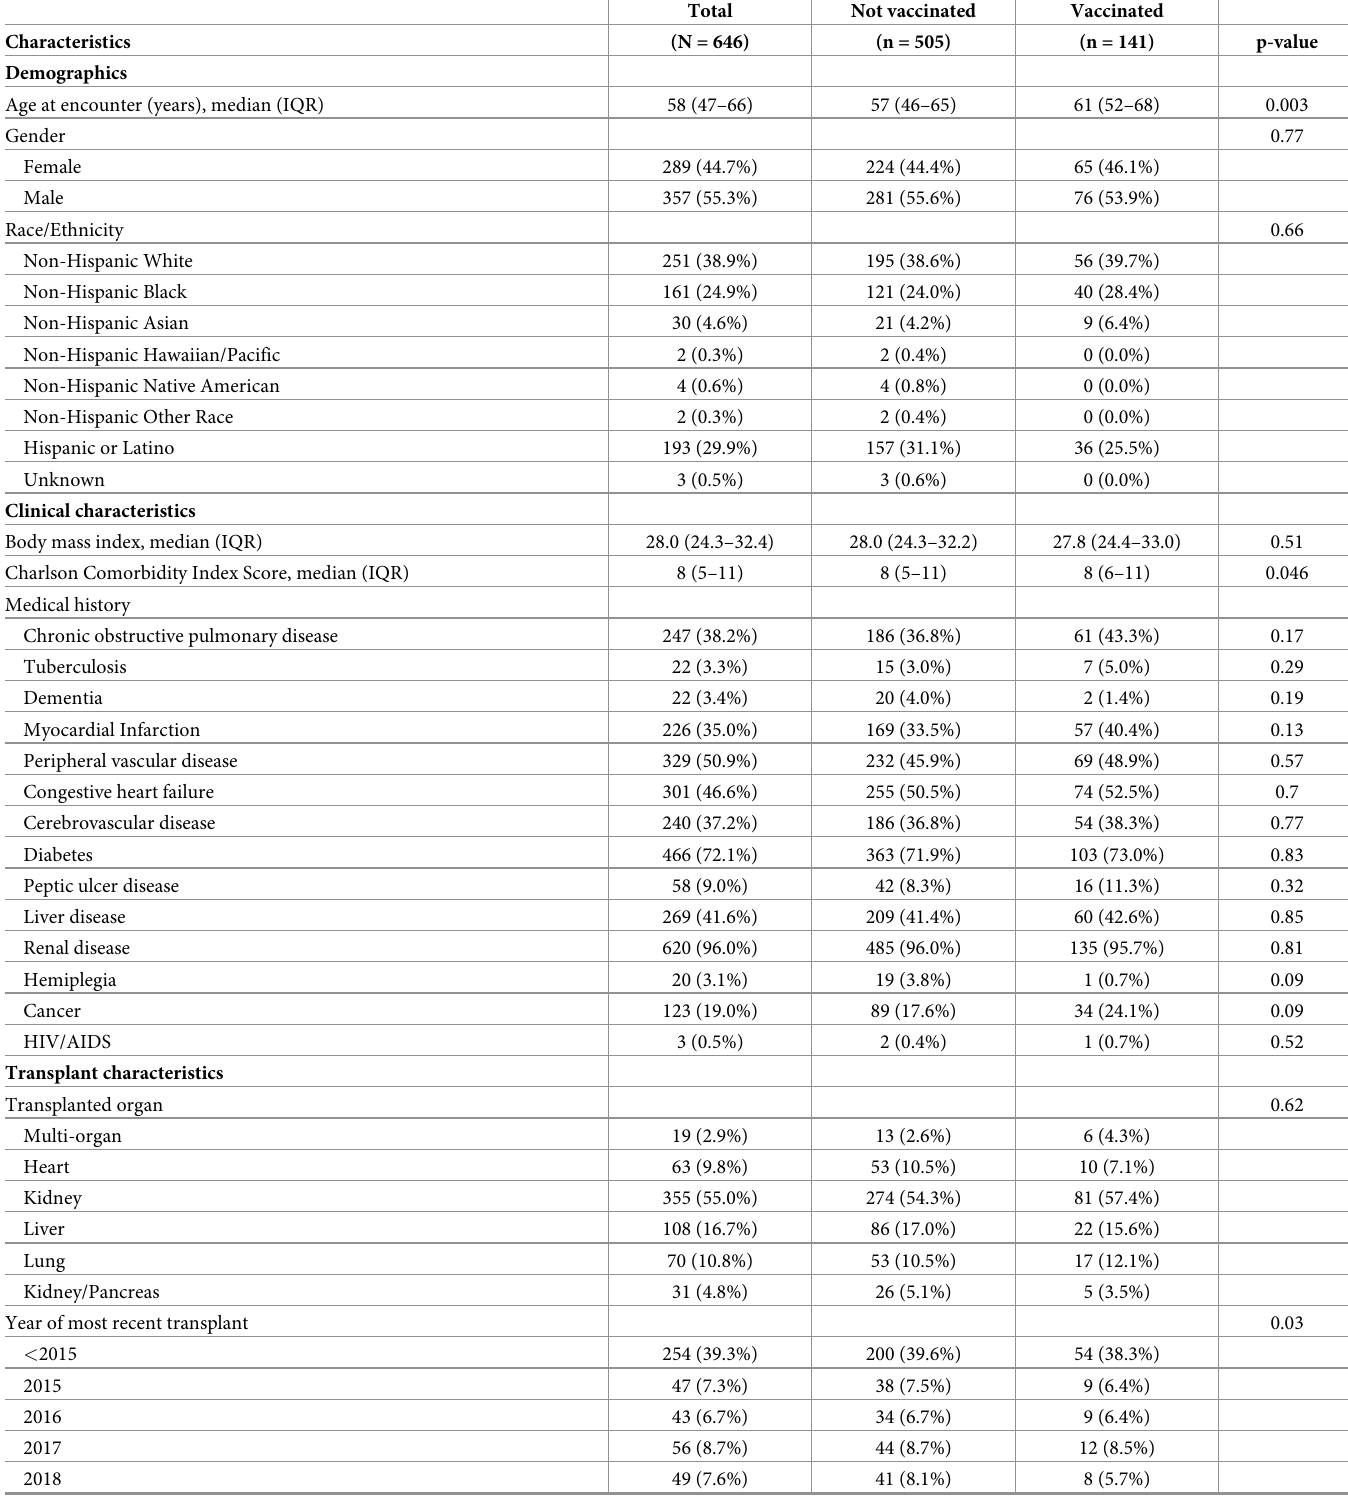
Table 1. Demographics and clinical characteristics of solid organ transplant recipients diagnosed with COVID-19 by vaccination